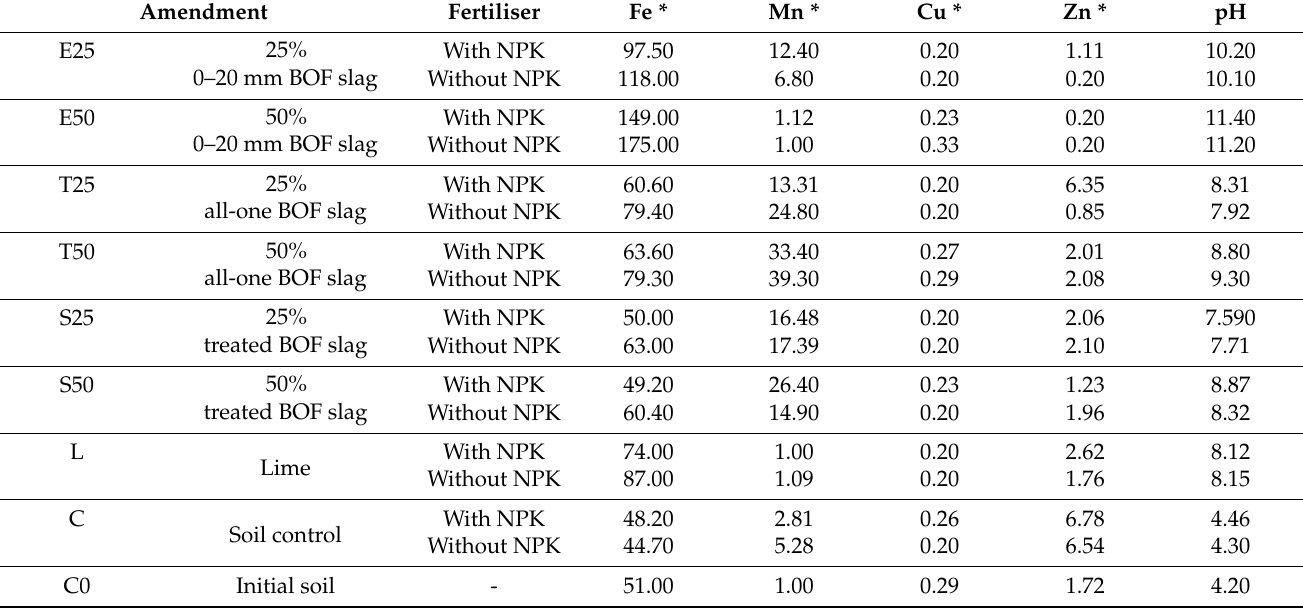
Table 7. Effect of amendments treatments on available micronutrients (mg kg − 1 ) and